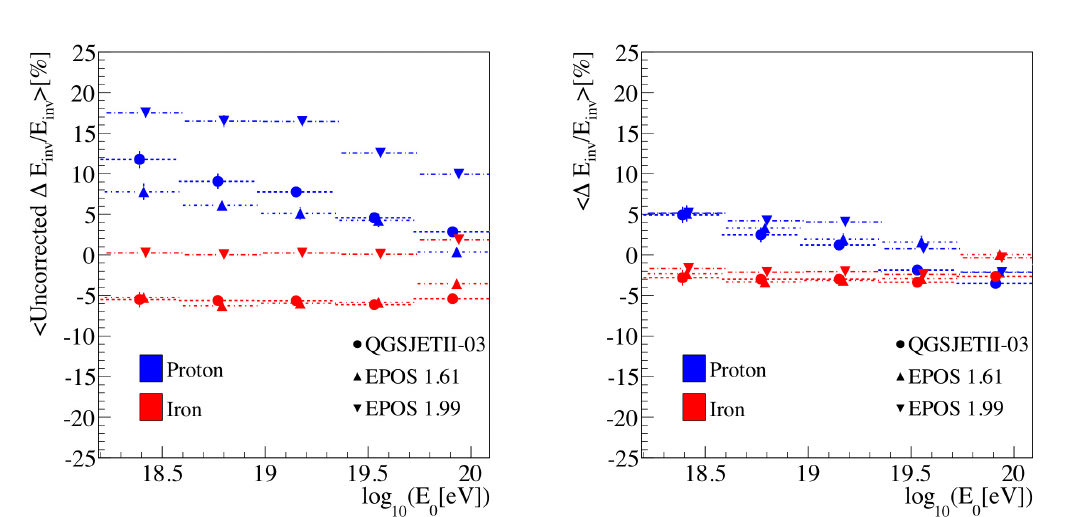
Figure 4. Average value of the relative di ff erence between the true value of E inv and the value of E inv reconstructed from S (1000) and X max using Eq. (10) before (right) and after (left) applying the correction due to the di ff erence among the simulations in the predictions of the number of muons and in the attenuation function, using